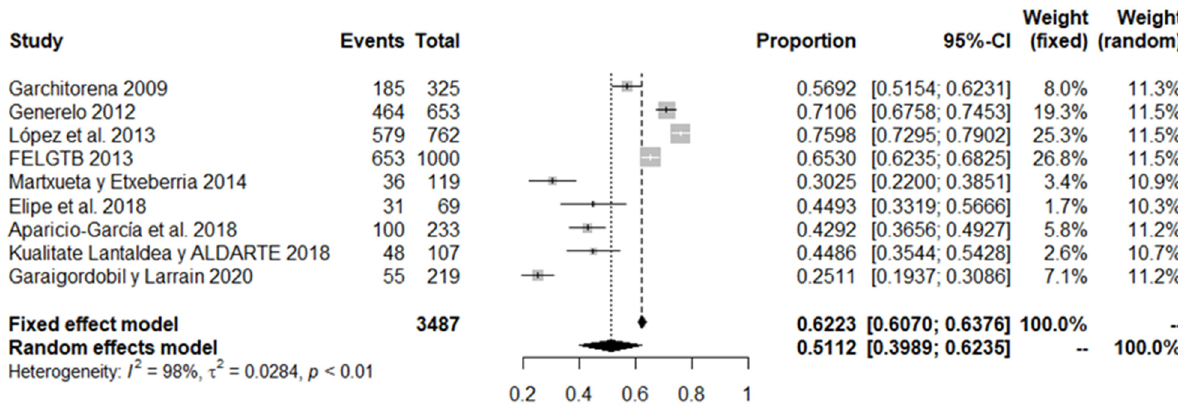
Figure 5. Forest plot of bullying victimisation among LGBT+ people studies.